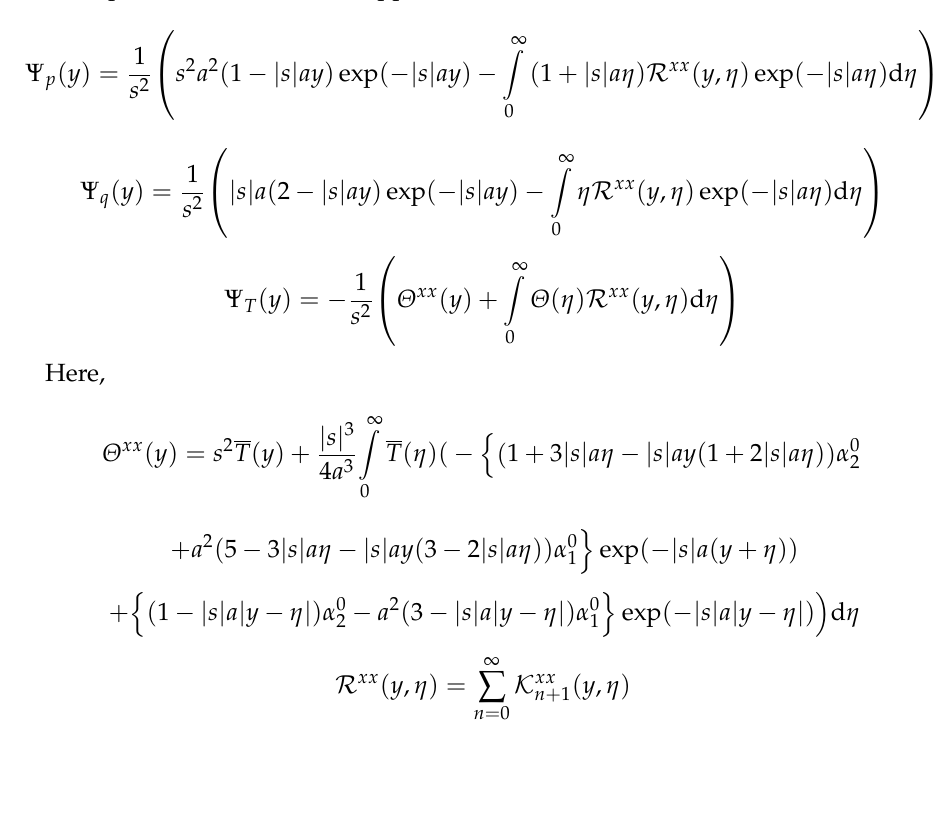
Table A1. Expressions for the real and imaginary parts λ Re